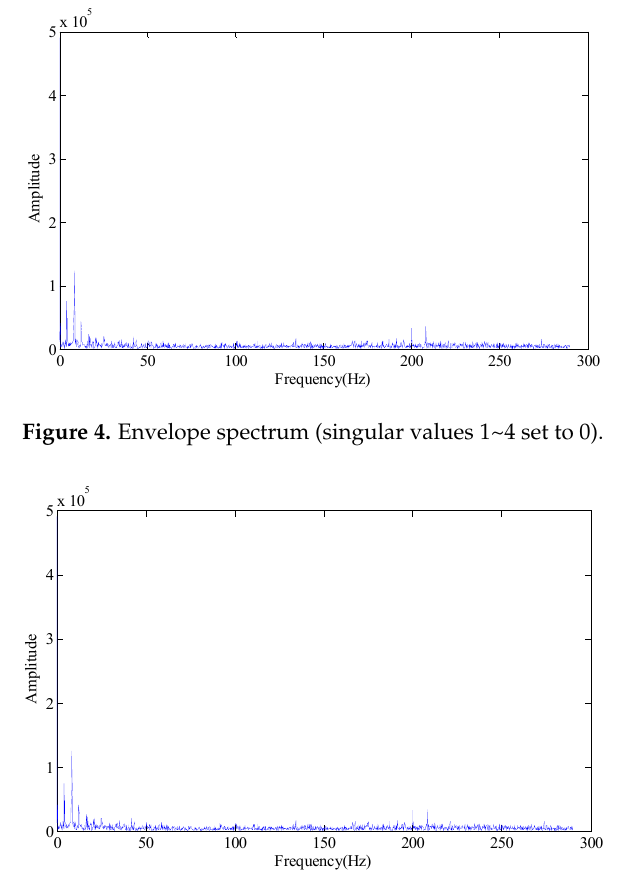
Figure 5. Envelope spectrum (singular values 1, 2, 7, 8 set to 0).